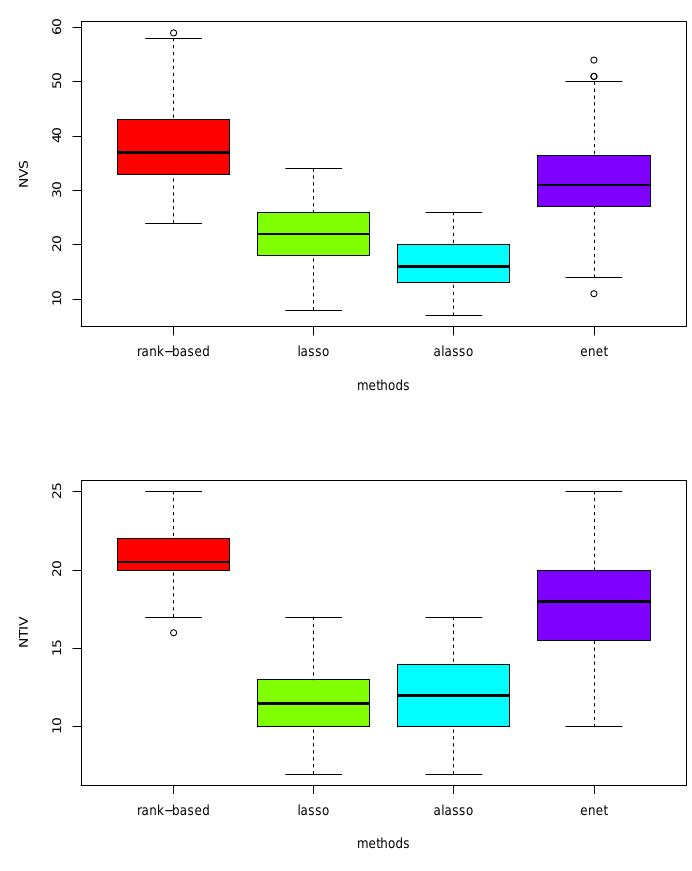
Figure 4. Boxplots of total number of variables (NVS) selected and the number of true important variables (NTIV) within the number of variables selected with four different models under scenario 3 based on 150